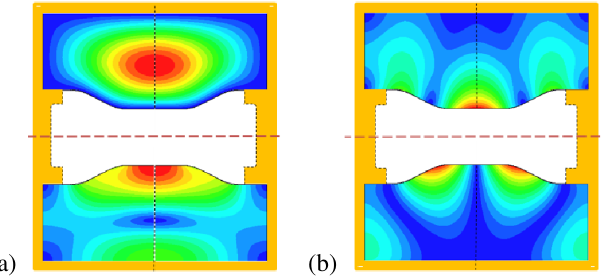
FIG. 10. Electric field pattern (top) and magnetic field pattern (bottom) for (a) the TE 011 mode and (b) the TEM 3 mode in a coaxial rf breakdown test cavity with necked center conductor. The white region is a removable center